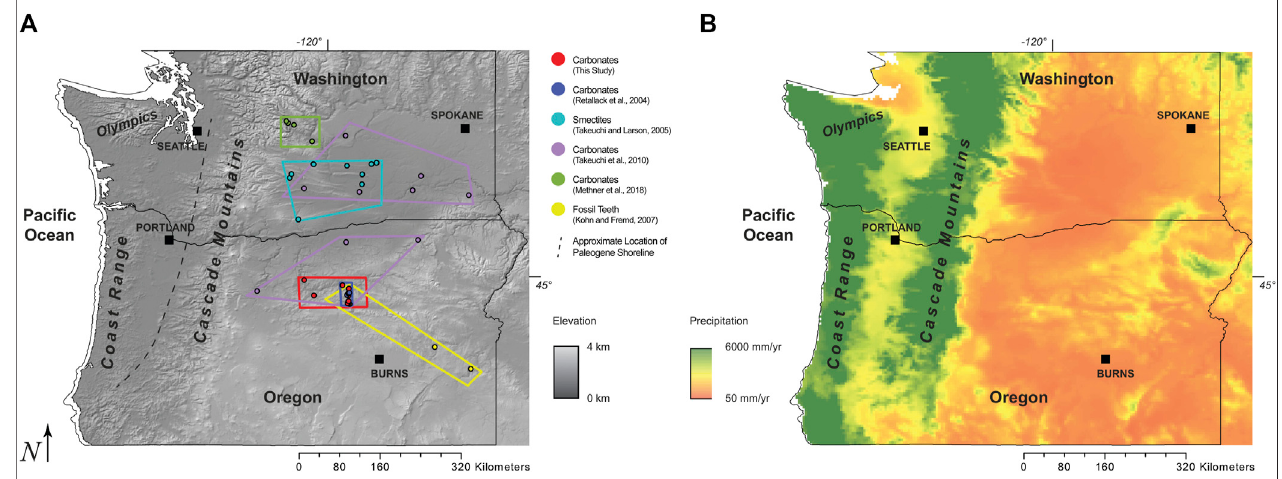
FIGURE1|(A) Locationmapshowingtheextentofnewdata(red)andpublisheddatasetsthroughoutthePaci fi cNorthwest.Elevationisshownasgreyscaleinkm. Dashed line shows the inferred Paleogene shoreline prior to the emergence of the Oregon Coast Range based on paleogeographic maps by Orr and Orr (1999) and references therein. Digital Elevation Model (DEM) is based on the United States. Geological Survey Global 30 Arc-Second GTOPO30 (https://doi.org/10.5066/ F7DF6PQS). (B) Map showing annual precipitation amount, averaged from 1981 – 2010 across the Paci fi c Northwest. Data Source: PRISM Climate Group (http://